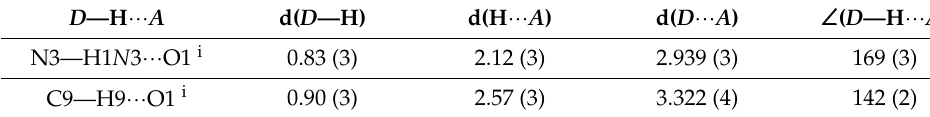
Figure 3. Molecular Structure of compound 14 .